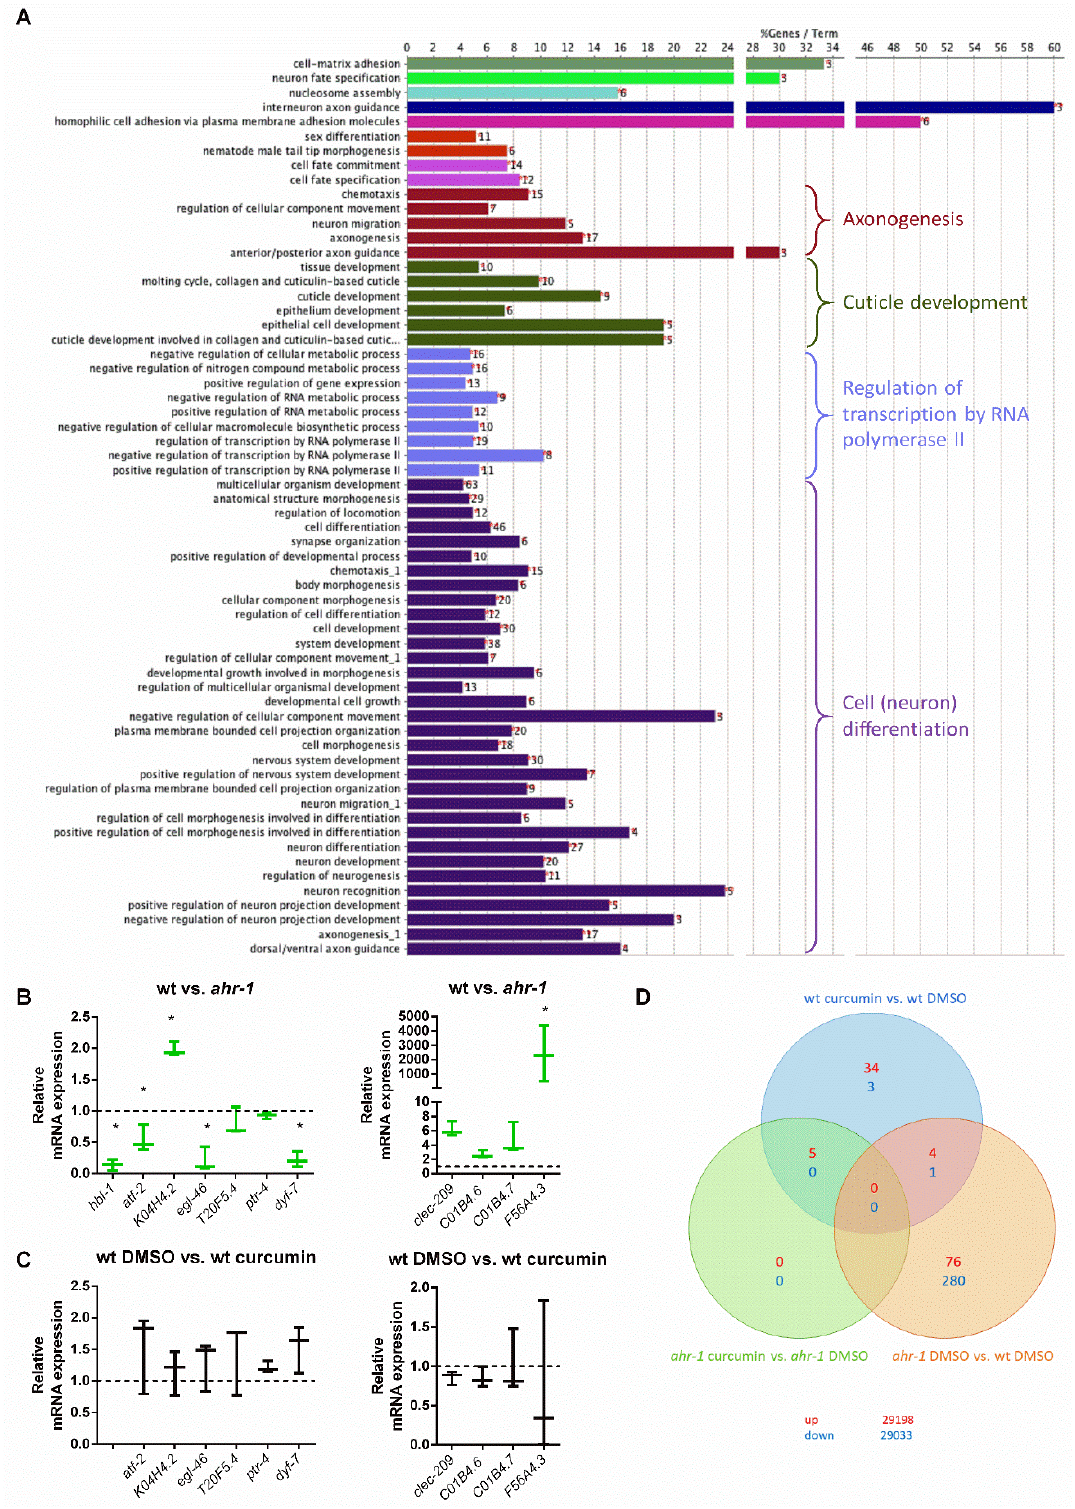
Figure 2. Genes differentially regulated by curcumin are primarily regulated in an ahr-1 -dependent manner. ( A ) Gene ontology (GO) enrichment for biological processes after GO term fusion in ahr-1 vs. wt. ( B , C ) The expression of the strongest down- and up-regulated genes between wt and ahr-1 [25] was assessed by qPCR in wt vs. ahr-1 ( B ) and DMSO- vs. curcumin-treated nematodes ( C ). Boxplots show data of 3 experiments. The expression is shown relative to DMSO-treated wt (dashed line). Statistical test: 1-way ANOVA with Tukey’s multiple comparisons test, * p -value < 0.05 vs. wt. ( D )